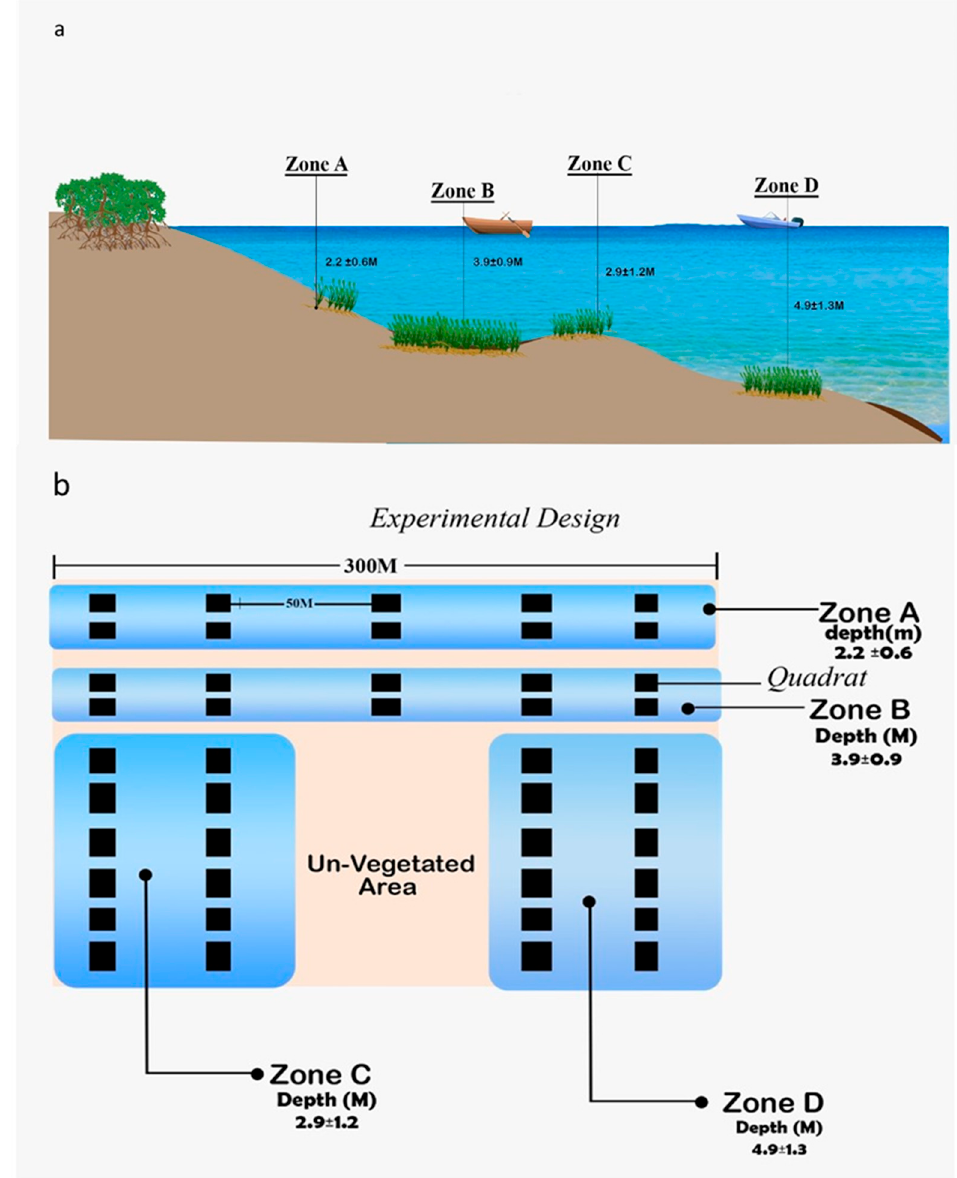
Figure 2. Diagrammatic representations of sampling design within the subtidal zone of Gazi Bay: ( a ) generalized north-to-south transect showing mean depth, and ( b ) aerial view showing the spatial arrangement of replicate sampling sites within each zone.